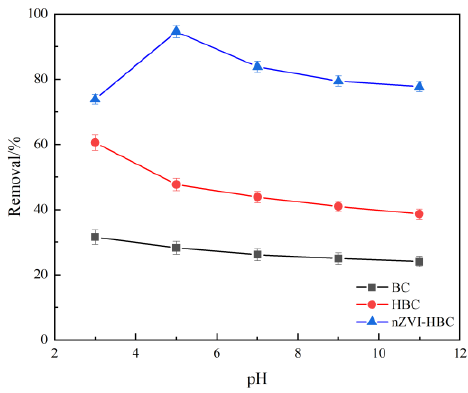
Figure 6. The effect of biochar addition on OTC removal rate.